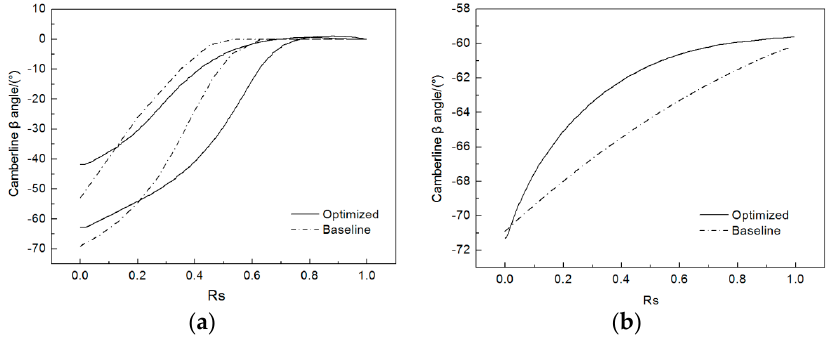
Figure 10. Blade angle distribution: ( a ) impeller; ( b ) radial diffuser.